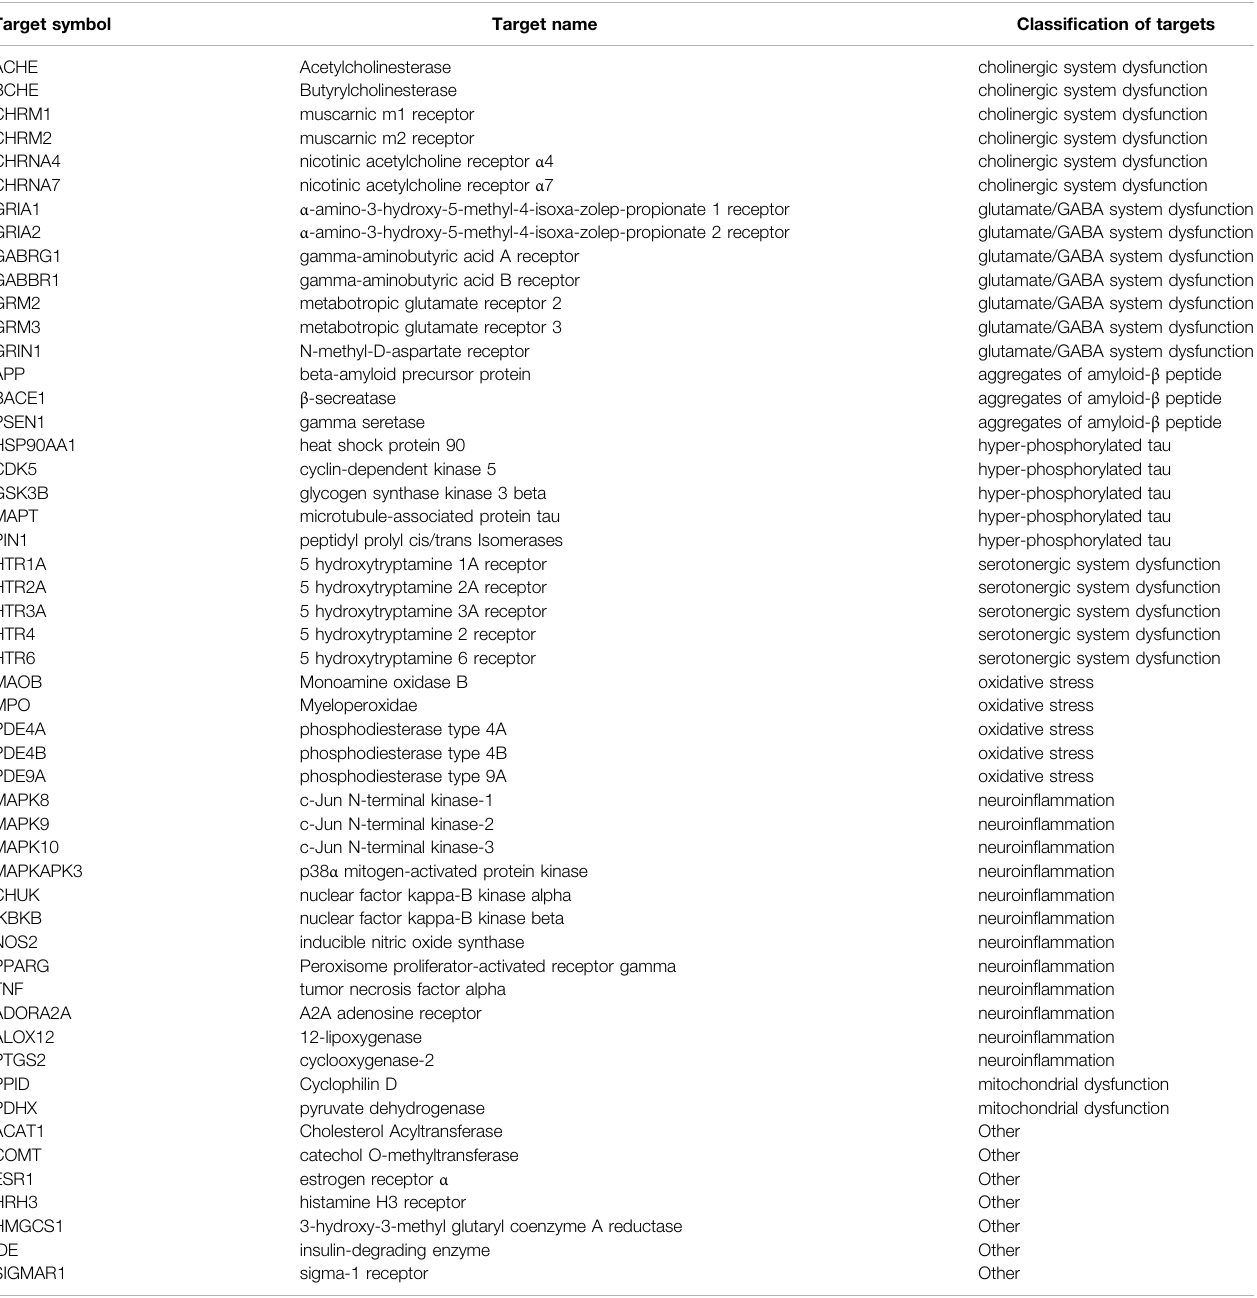
TABLE 1 | Basic information of AD-related